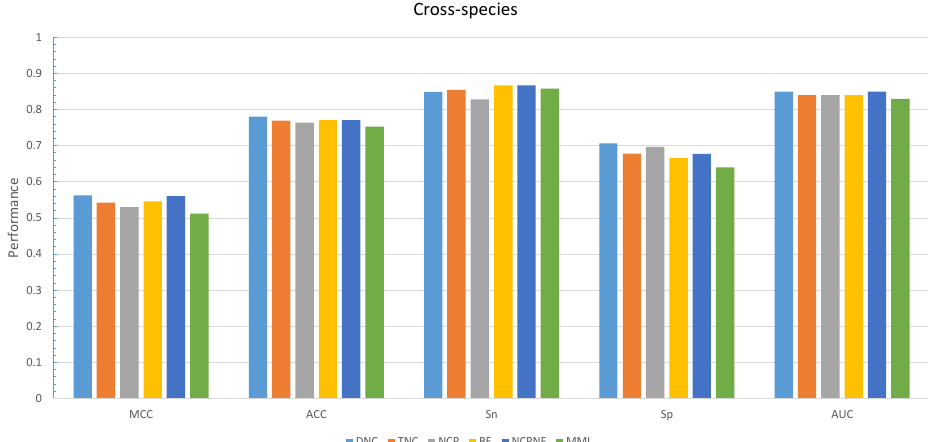
Figure 9. Grapical illustration of performance comparison between six encoding methods on the independent cross-species dataset.